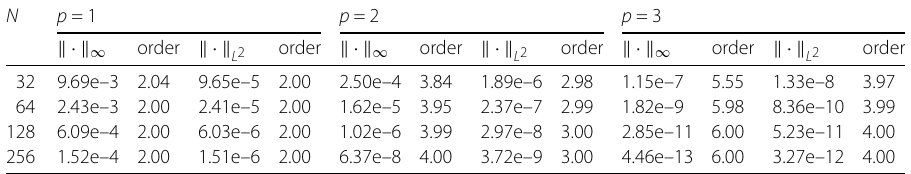
Table 7 Improved graded mesh, λ = 2, τ (cid:2) = min { 0.5,– (cid:2) ( p + 1)ln (cid:2) } , (cid:2) = 10 –6 N p = 1 p = 2 p =